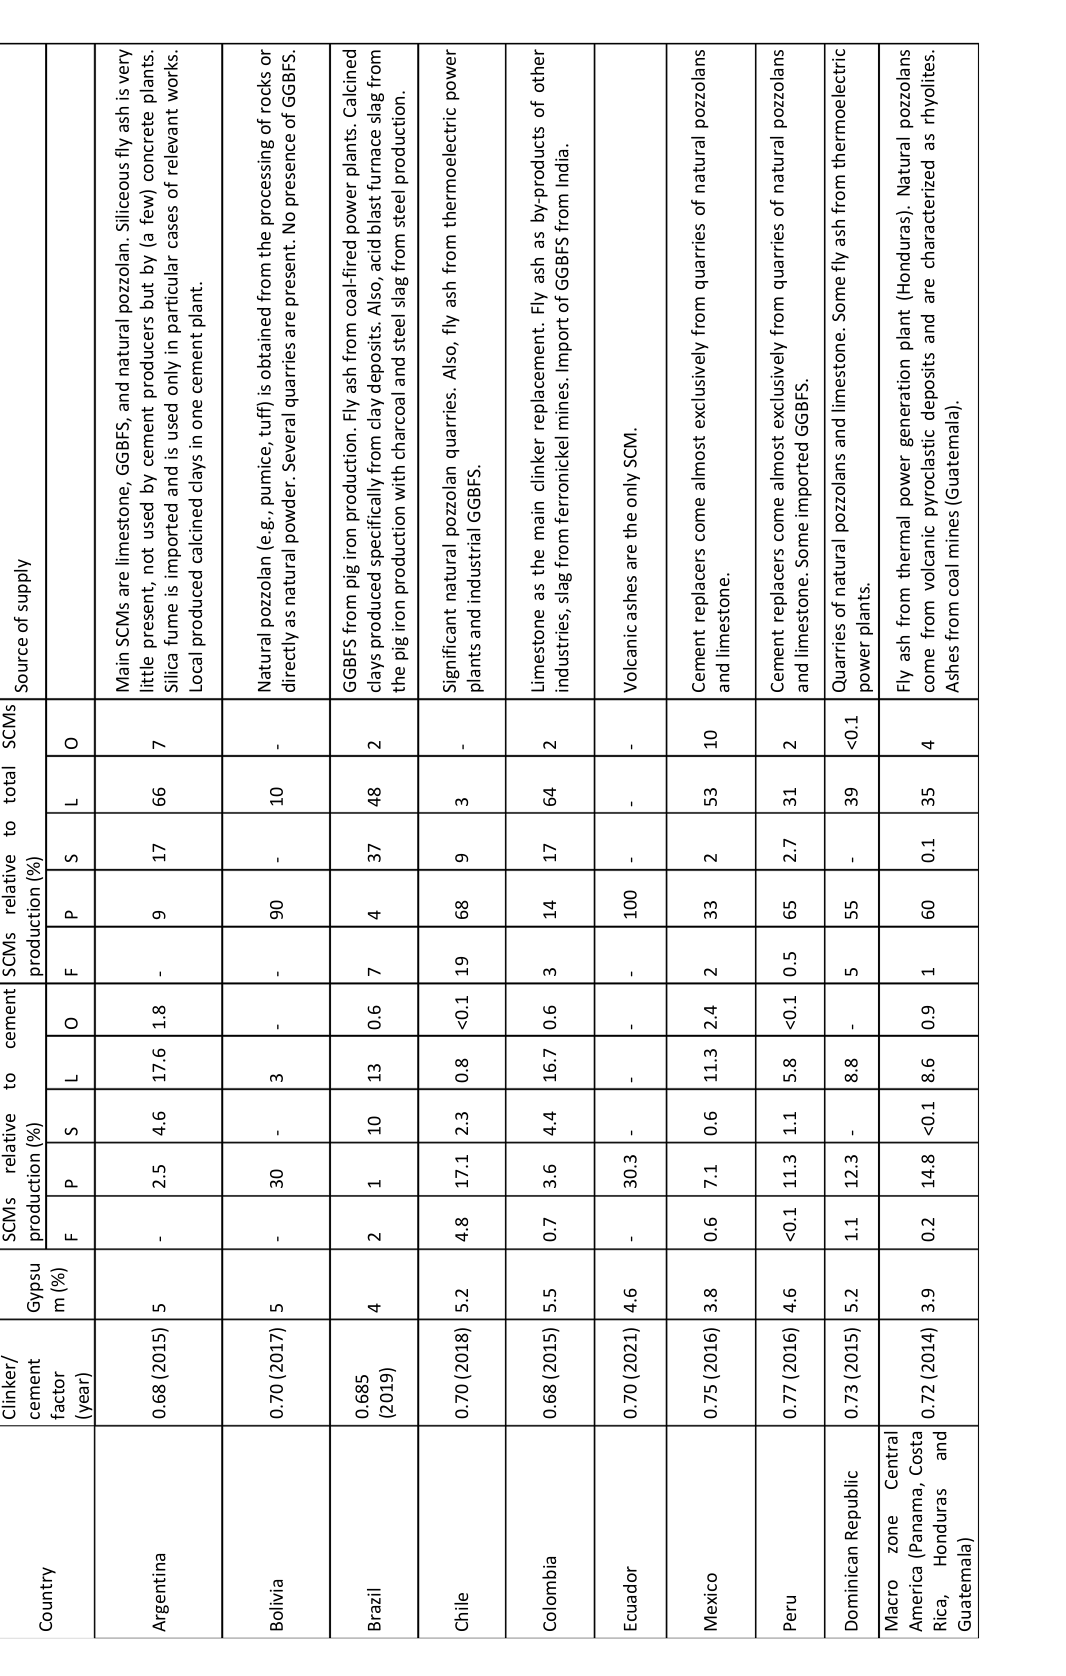
Table 1. SCMs in the LAC cement industry (F: fly ash; P: natural pozzolan; S: GGBFS; L: limestone; O: others). Note: ‘Gypsum’ is reported as the impure amount of raw material that is industrially added during cement production, i.e. including